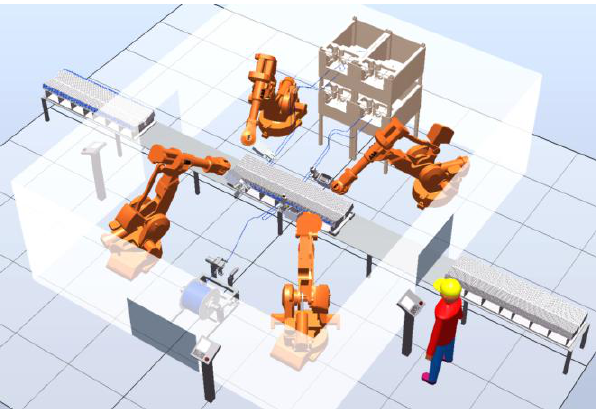
Figure 3. A simulation snapshot of the suggested robotized cable winding cell, created in ABB